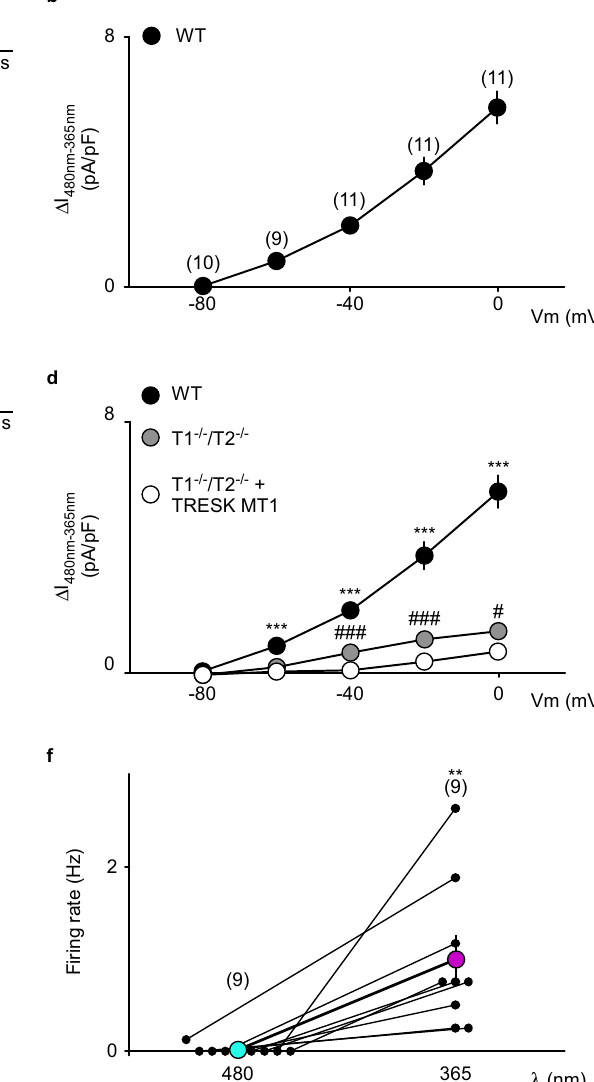
LAKI(10 µ M)uponalternatingilluminationat480nm(blue)and365nm(magenta). f Graphsummarizingtheaverage fi ringrateofWTTGneurons. n wasobtainedfrom 6micefromtwoindependentexperiments.Statisticalsigni fi cancewasdetermined by a two-sided paired t -test (** p =0.0053). Data were represented as mean±SEM. The numbers of tested neurons are indicated in parentheses on the